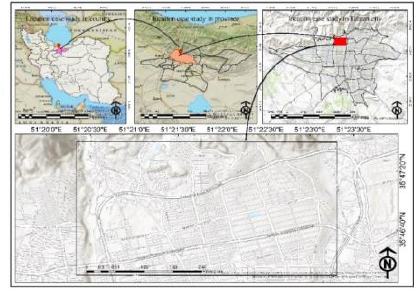
Figure1: Case study area and its location in the city, the province, and the country